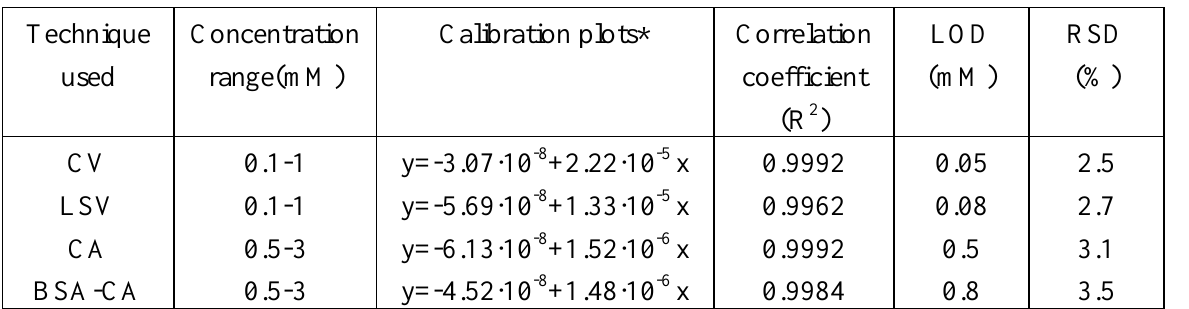
Table 1. The analytical parameters of amperometric detection of oxalic acid at an EG-PS electrode using different